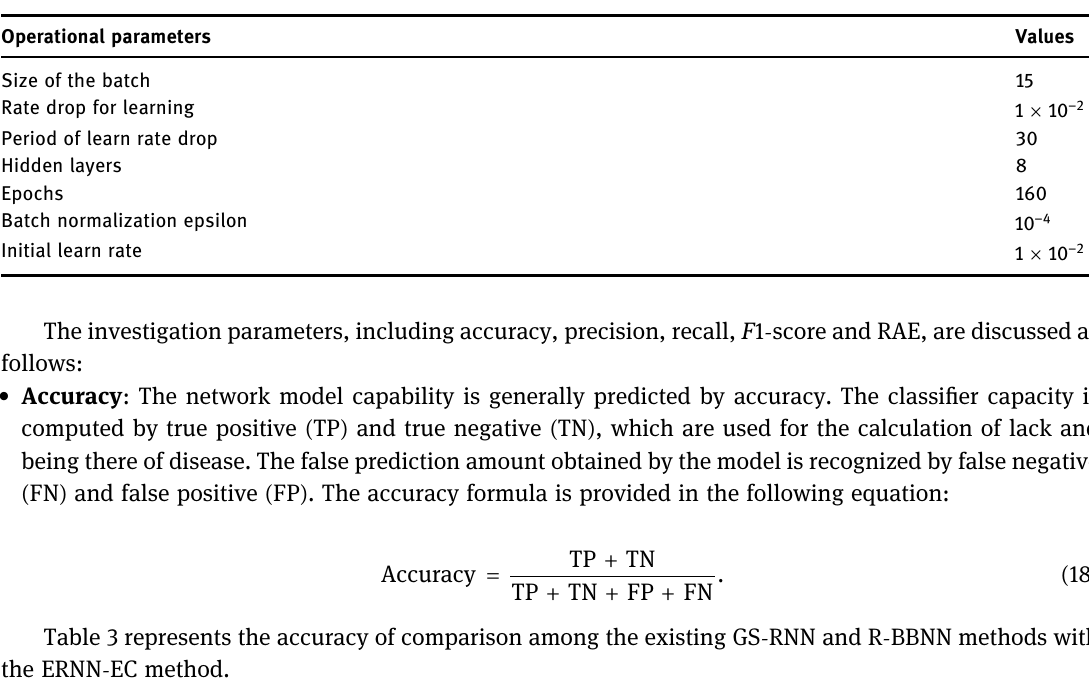
Table 2: Parameters for operation